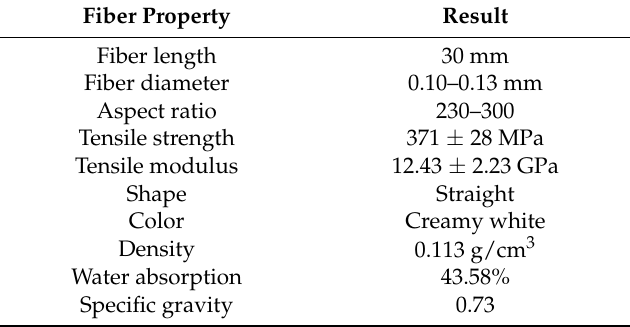
Table 1. Properties of sisal